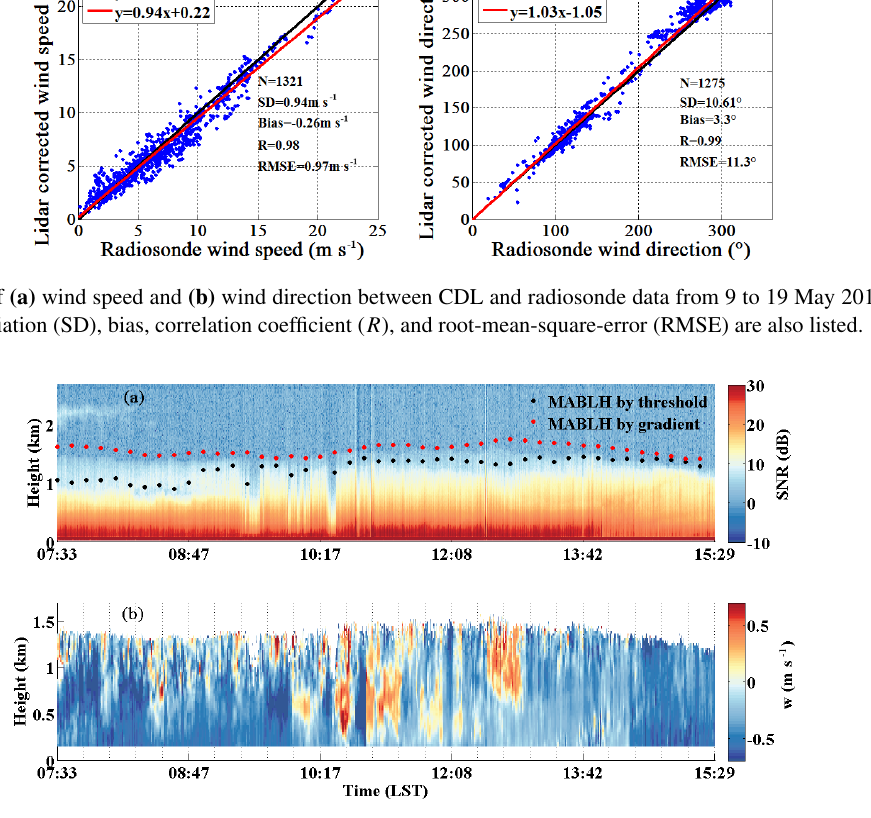
Figure 9. Example measurement from 07:33 to 15:29LT on 14 May 2014: (a) Time-Height-Intensity of SNR and retrieved MABL height using SNR threshold and gradient method (black and red solid circles, respectively). (b) Time-Height-Intensity of vertical velocity after attitude